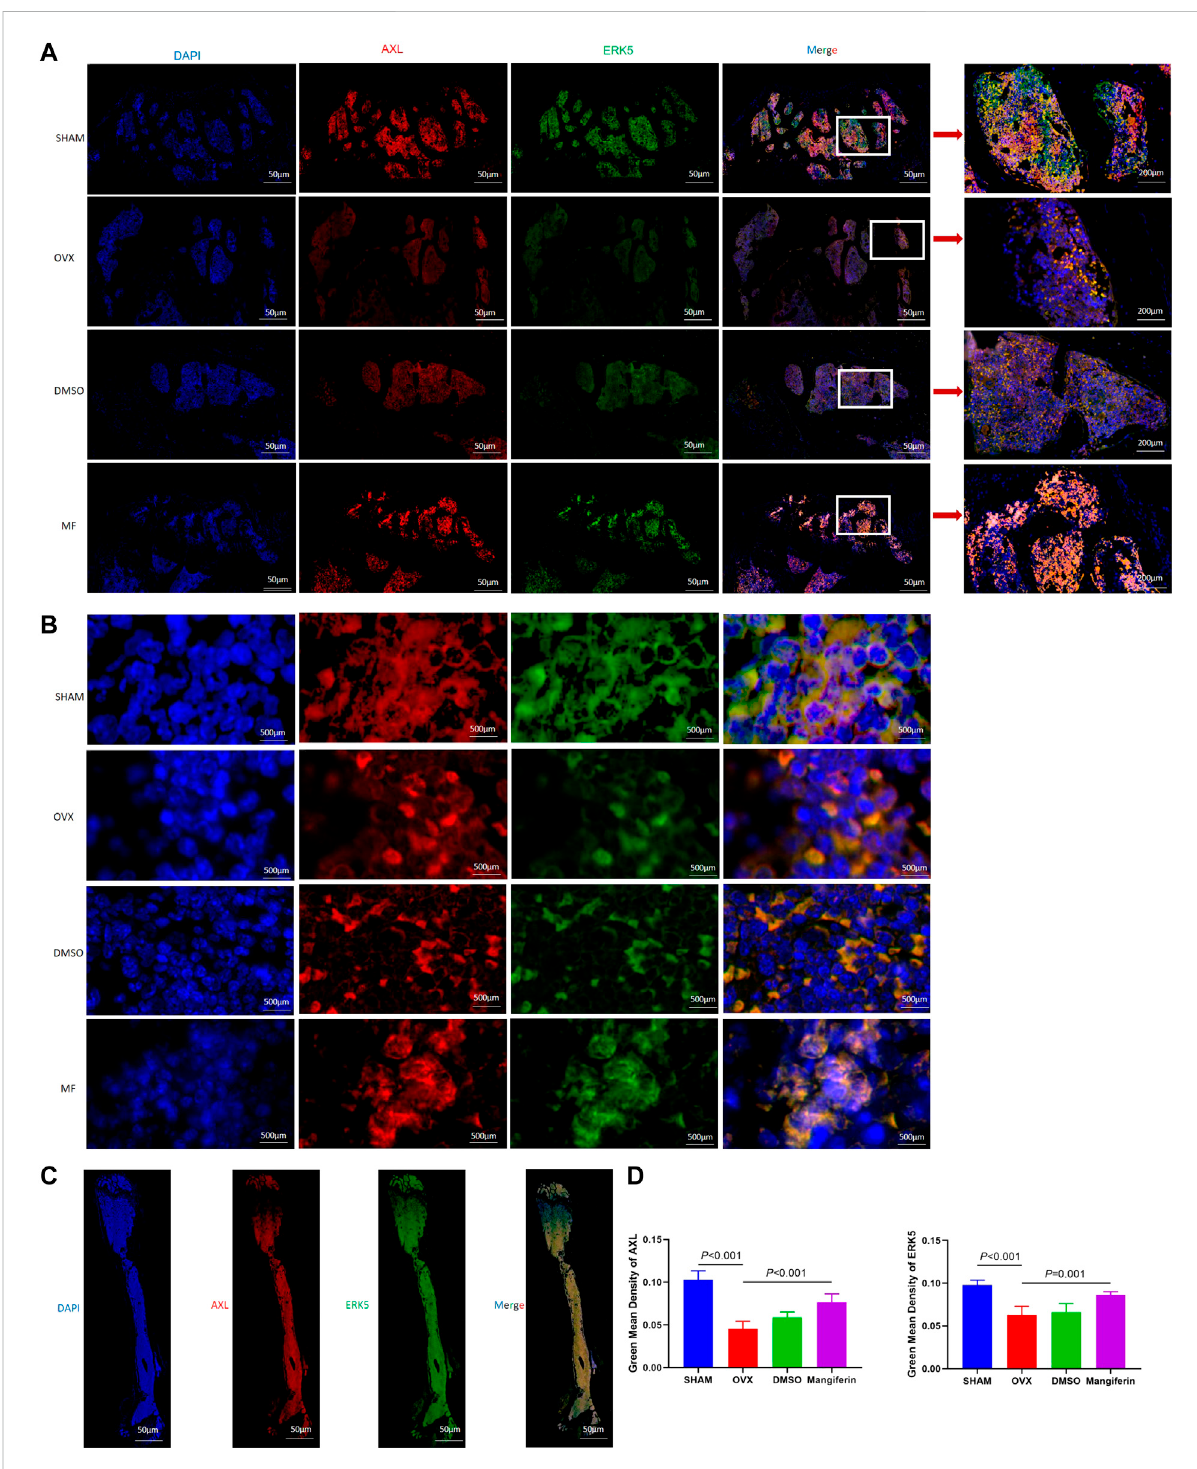
FIGURE 9 Immuno fl uorescenceoftheAXLandERK5inthefemur. (A) LocalviewofAXLandERK5expressioninthefemoralmetaphysis. (B) Localizationof expression of AXL and ERK5 in the femoral metaphysis, ampli fi cated images. (C) Panoramic view of the femur, DAPI (blue), ERK5 (green), AXL (red), and merged version. (D) The green mean density of AXL and ERK5 in the OVX and DMSO groups signi fi cantly decreased when compared with the SHAMgroup( p < 0.001,respectively).Thegreenmeandensity ofAXLandERK5signi fi cantly increasedinthemangiferingroupwhencompared with the OVX and DMSO groups ( p < 0.05, respectively) Note: MF,